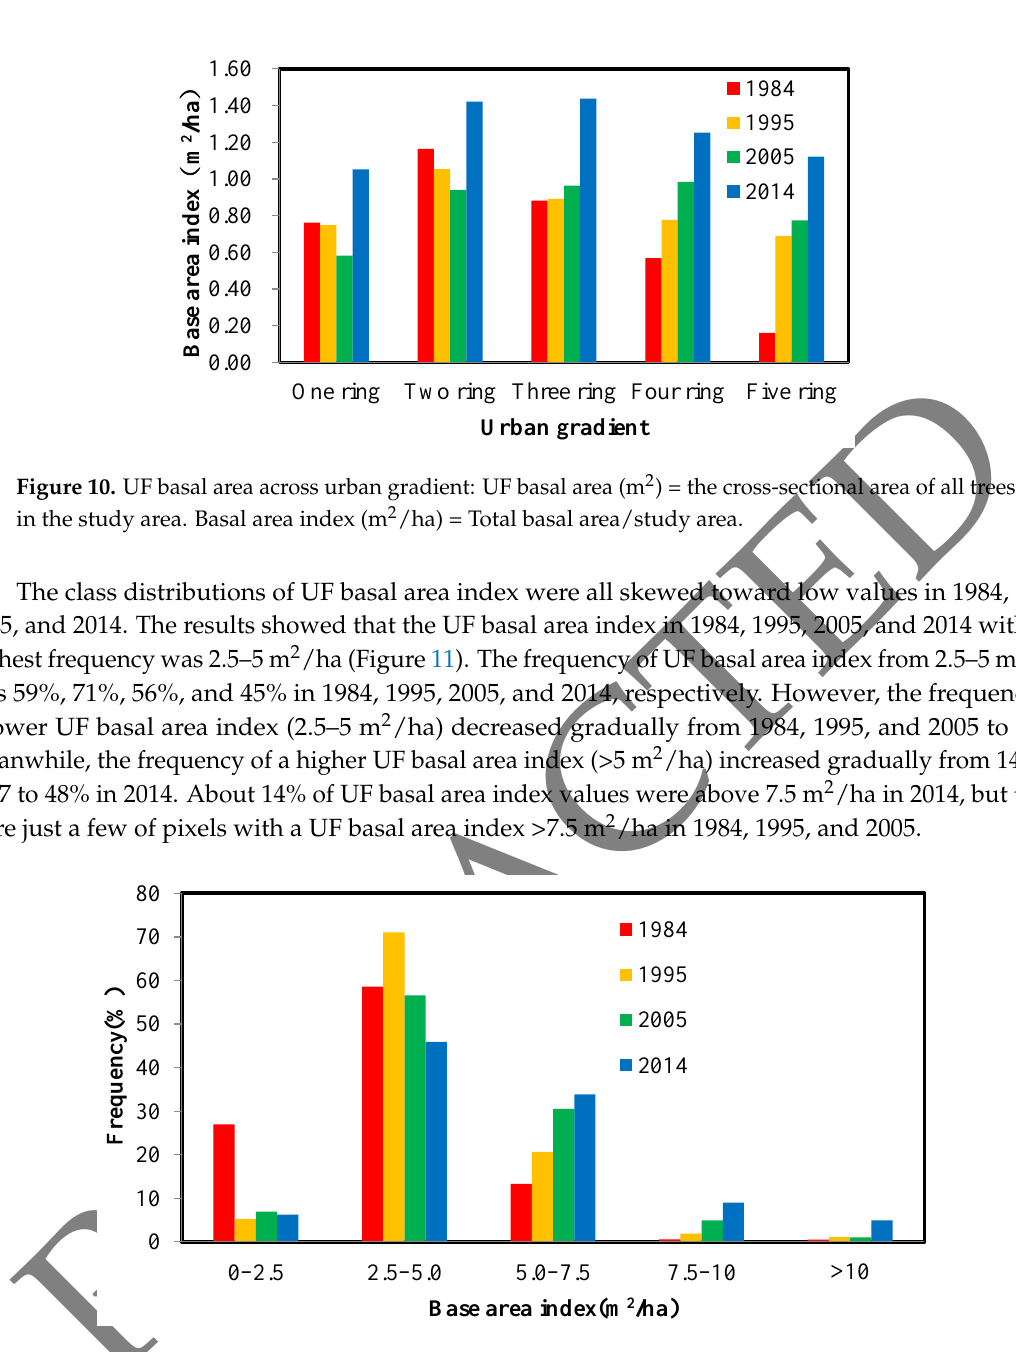
Figure 11. Histograms of the frequency statistics for UF basal area index, calculated from pixels with UF in the study area of Changchun, China.